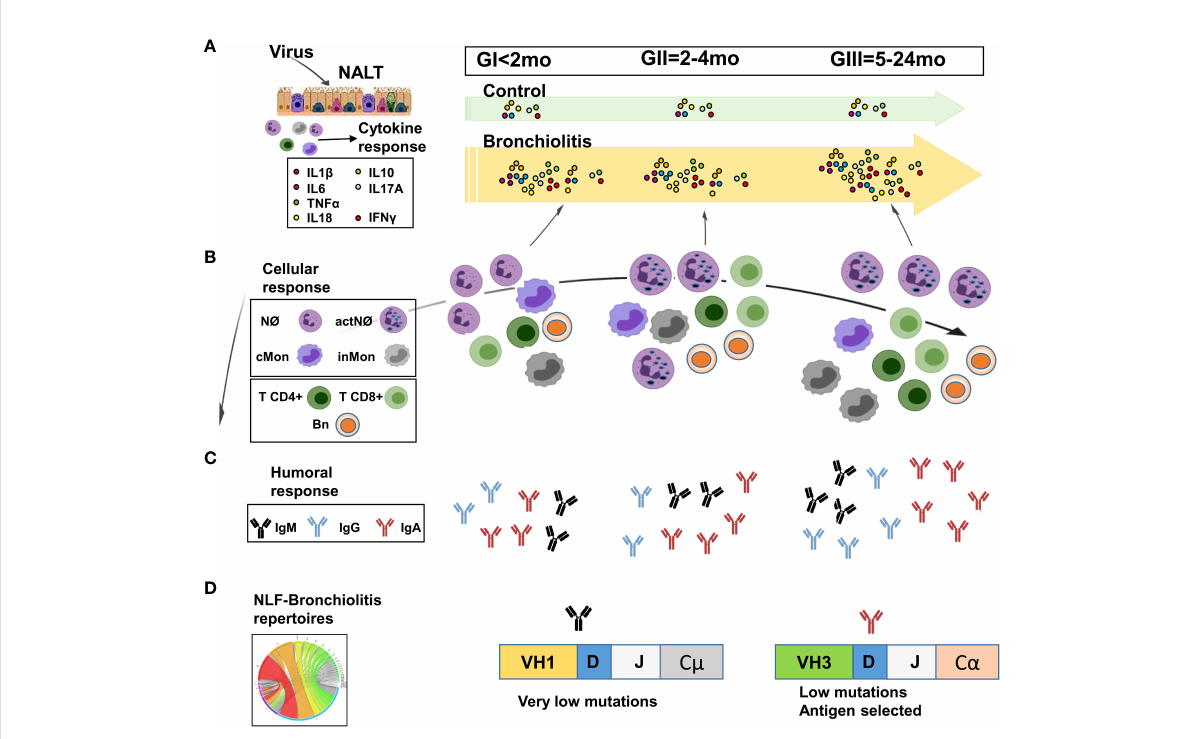
FIGURE 8 Scheme of the proposed age-dependent nasopharynx-associated lymphoid tissue (NALT) responses in children with mild/moderate bronchiolitis pathology. The cytokine, immunoglobulin and cellular content in NLF samples varies with the age of the children affected with bronchiolitis. (A) Pro-in fl ammatory and regulatory cytokines are present in all NLF bronchiolitis samples at higher levels than in these from controls. (B) Heterogeneous combinations of CD45 + innate and adaptive cell types are detected in NLF from patients and not in controls. Neutrophils (N f s) are predominant in all NLF samples groups, which also contain classical and intermediate monocytes (cMon and inMon) and lymphocytes, these two latter increasing in children older than 2 months (GII/GIII), in which activated N f s (actN f s) with increased complexity and cMon and inMon, T cells (CD4 + and CD8 + ) and CD19 + cells were found. (C) IgM, IgGs and IgA levels are present at higher amounts than in age-matched controls. In addition, IgG levels highly augment in GIII infants. (D) Local B cell repertoires were determined by analyzing the presence of VH rearrangements in NLF samples, which displayed IgA- sequences with low mutations but antigen selection in GII/GIII infants. Created with